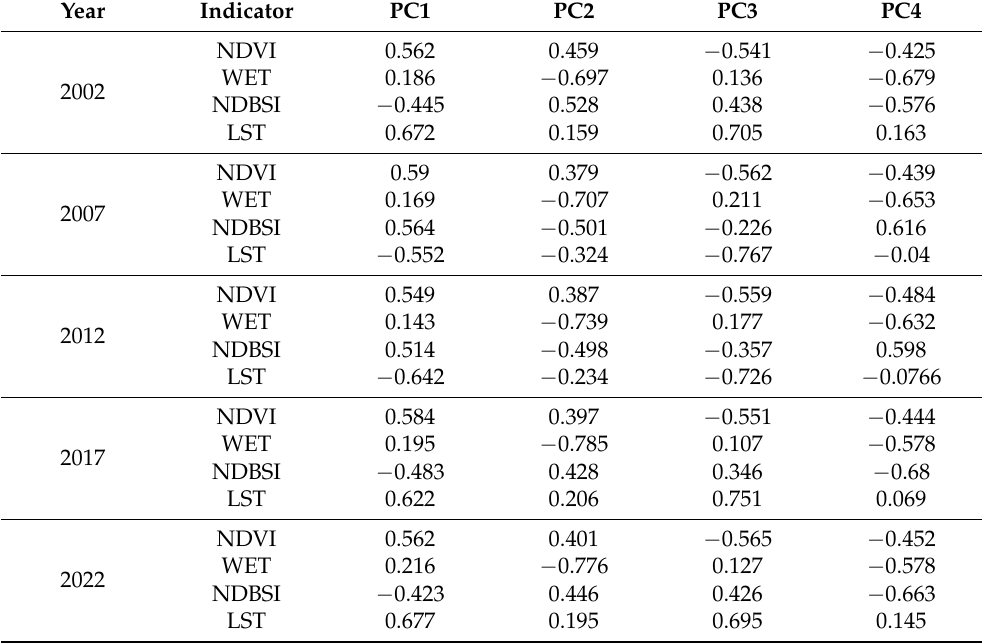
Table 2. Calculation results of the four indicators of RSEI in the study area.